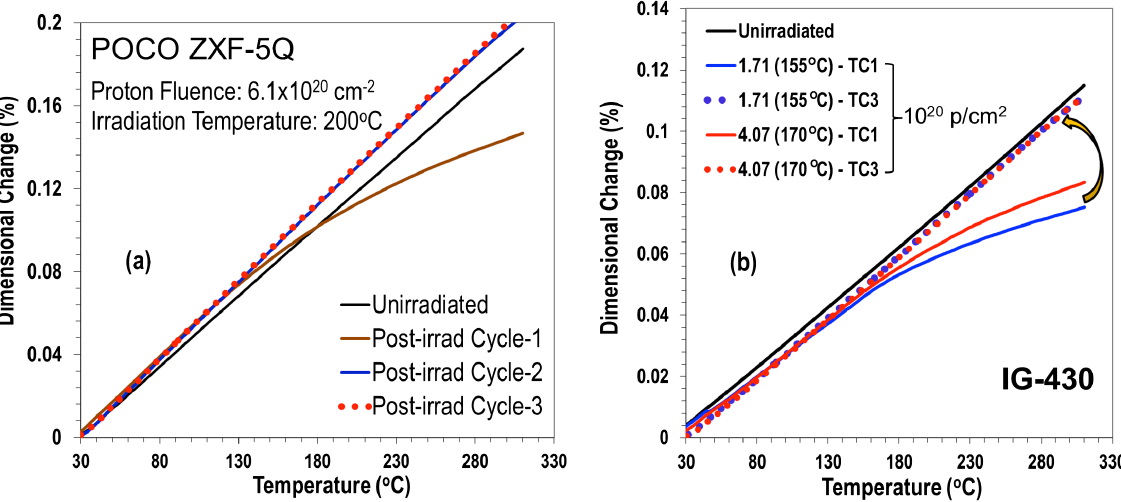
FIG. 9. (a) Thermal cycle annealing of irradiated POCO graphite over three postirradiation cycles to 310 °C to fluence of 6 . 1 × 10 20 p = cm 2 and irradiation temperature of 200 °C and (b) postirradiation annealing of IG 430 irradiated to two fluence levels and corresponding irradiation